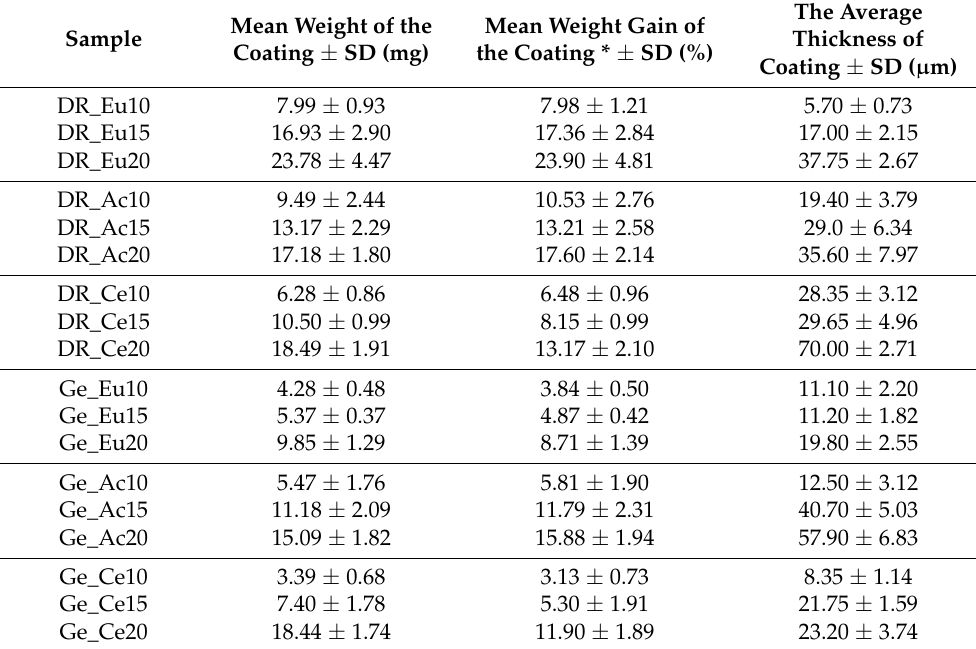
Table 3. Obtained weight of coatings samples dipped in different polymer dispersions. The thickness of polymer coating layers. Mean values ± SD ( n = 20).